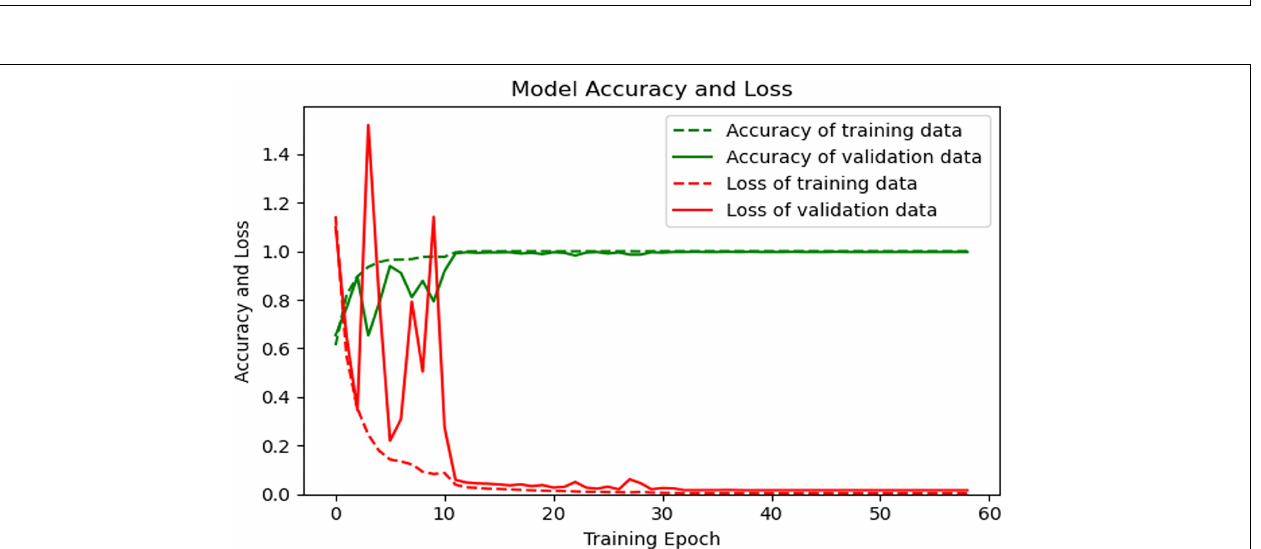
FIGURE 8 | Loss and accuracy of the model on the training set and the verification